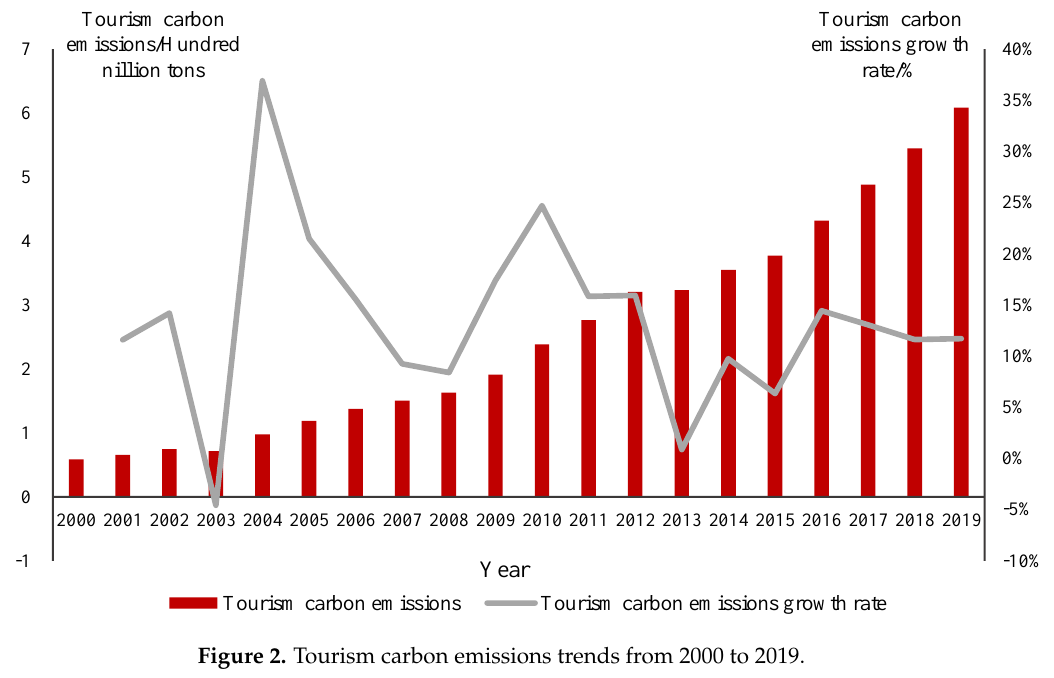
Figure 2. Tourism carbon emissions trends from 2000 to 2019.